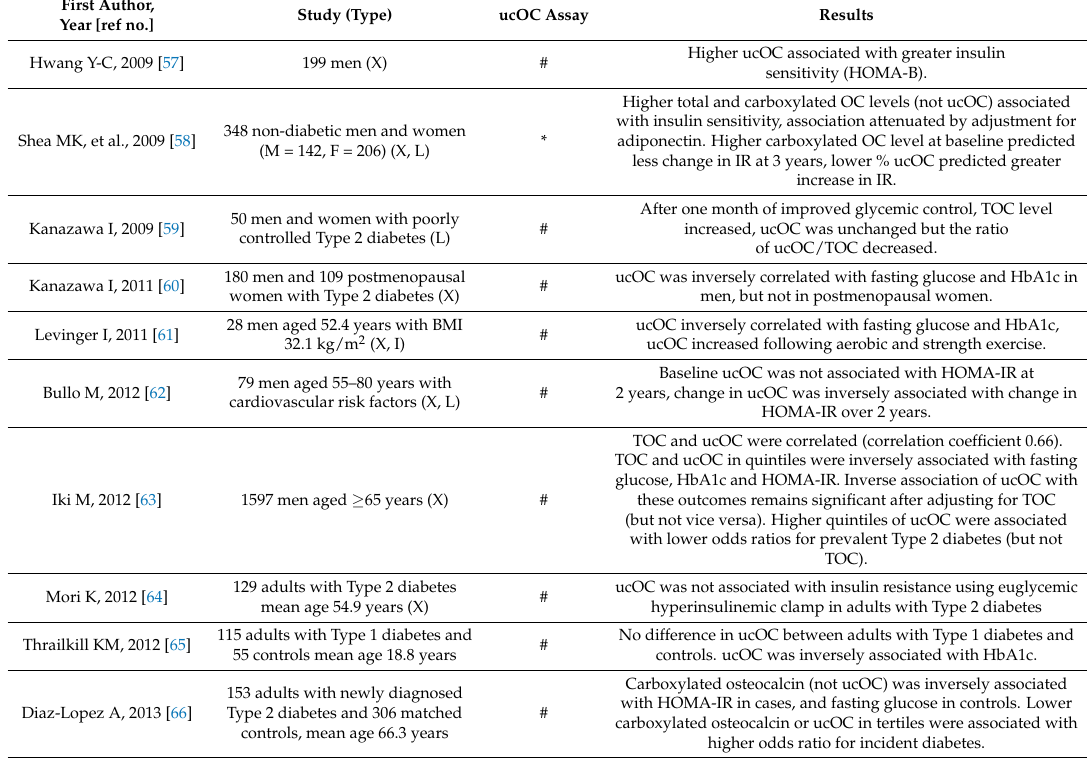
Table 2. Selected studies examining associations of undercarboxylated osteocalcin (ucOC) with insulin resistance, metabolic syndrome and diabetes in men and women are summarised. X = cross-sectional analysis, L = longitudinal analysis, I = interventional component, HOMA = homeostasis model assessment, HOMA-B = β -cell activity, HOMA-IR = insulin resistance, TOC = total